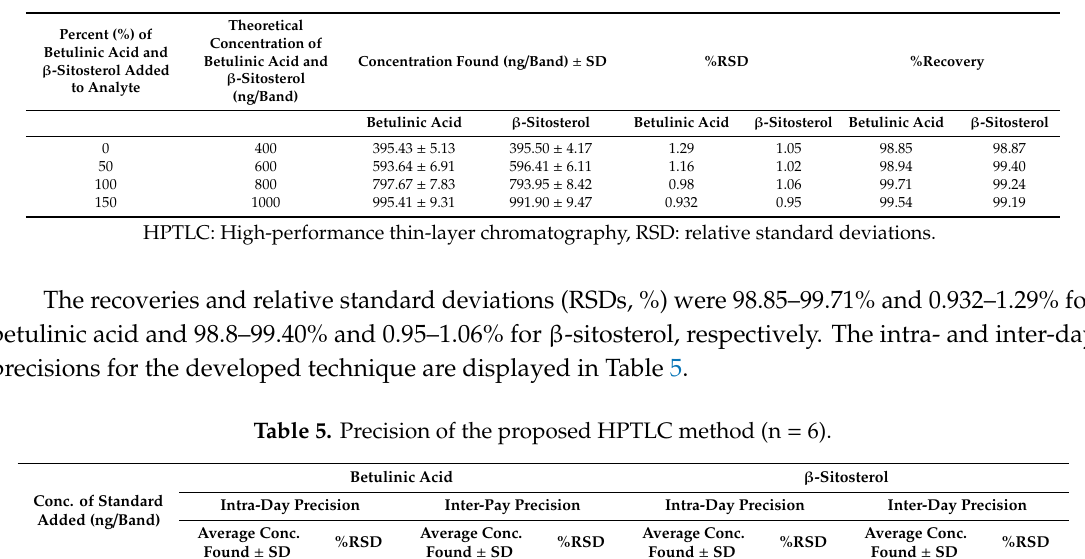
Table 4. Recovery as accuracy studies of the proposed HPTLC method (n = 6).